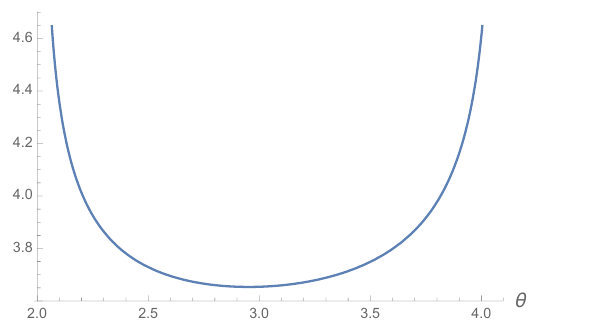
Figure 14. Plot of t c 2 against θ for r = 0 . 1 , λ = 0 . 001 , c 1 = 0 , c 2 = − 0 . 1 : t c 2 → ∞ as θ → θ 1 or θ → θ 2